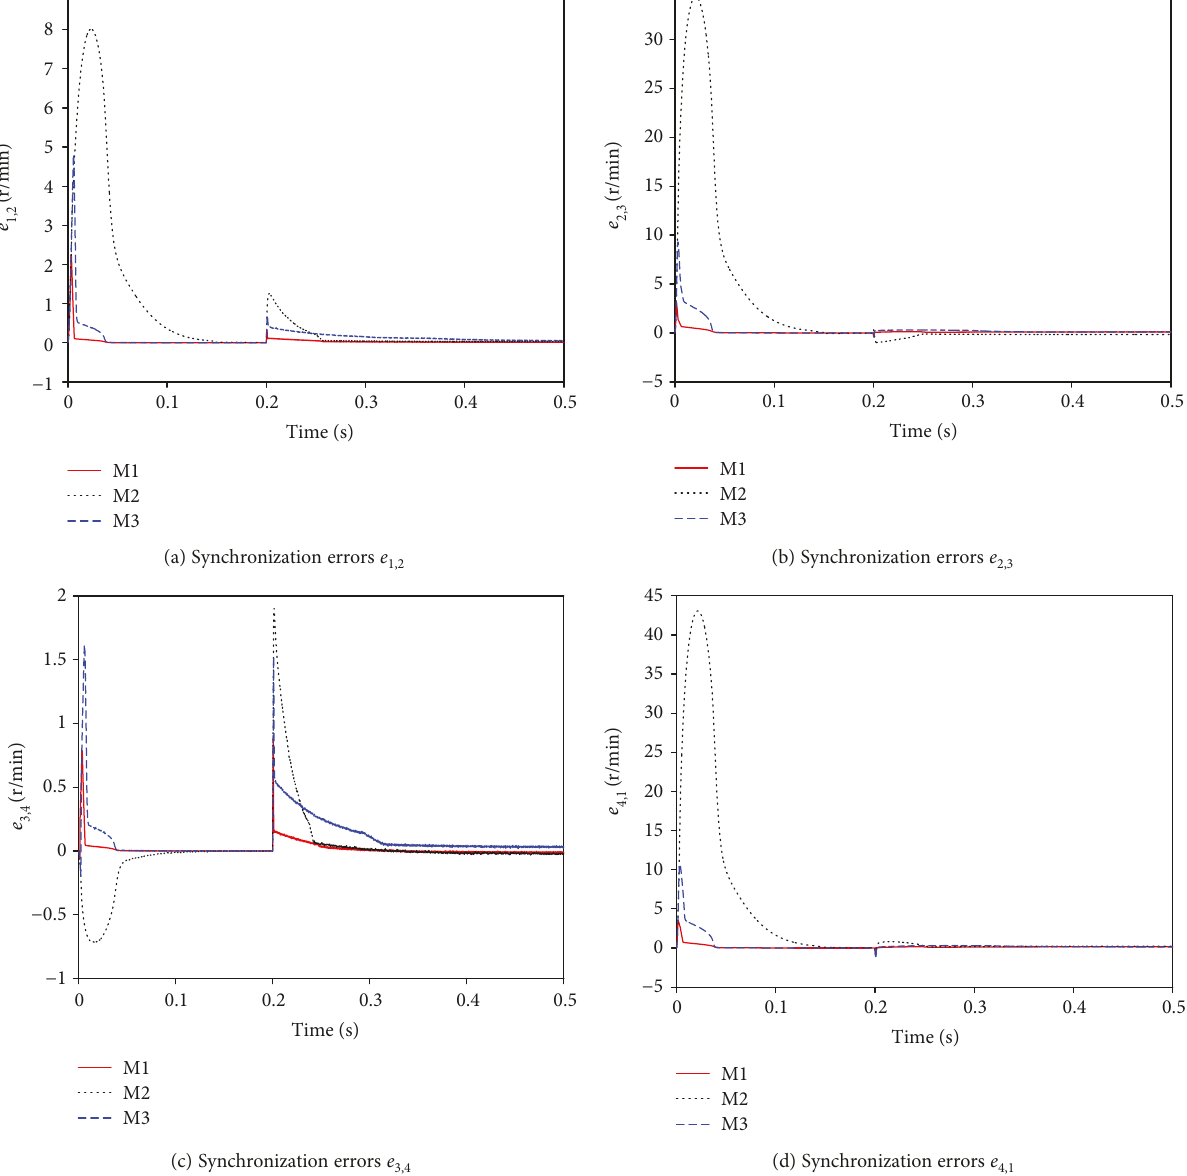
Figure 7: Synchronization error